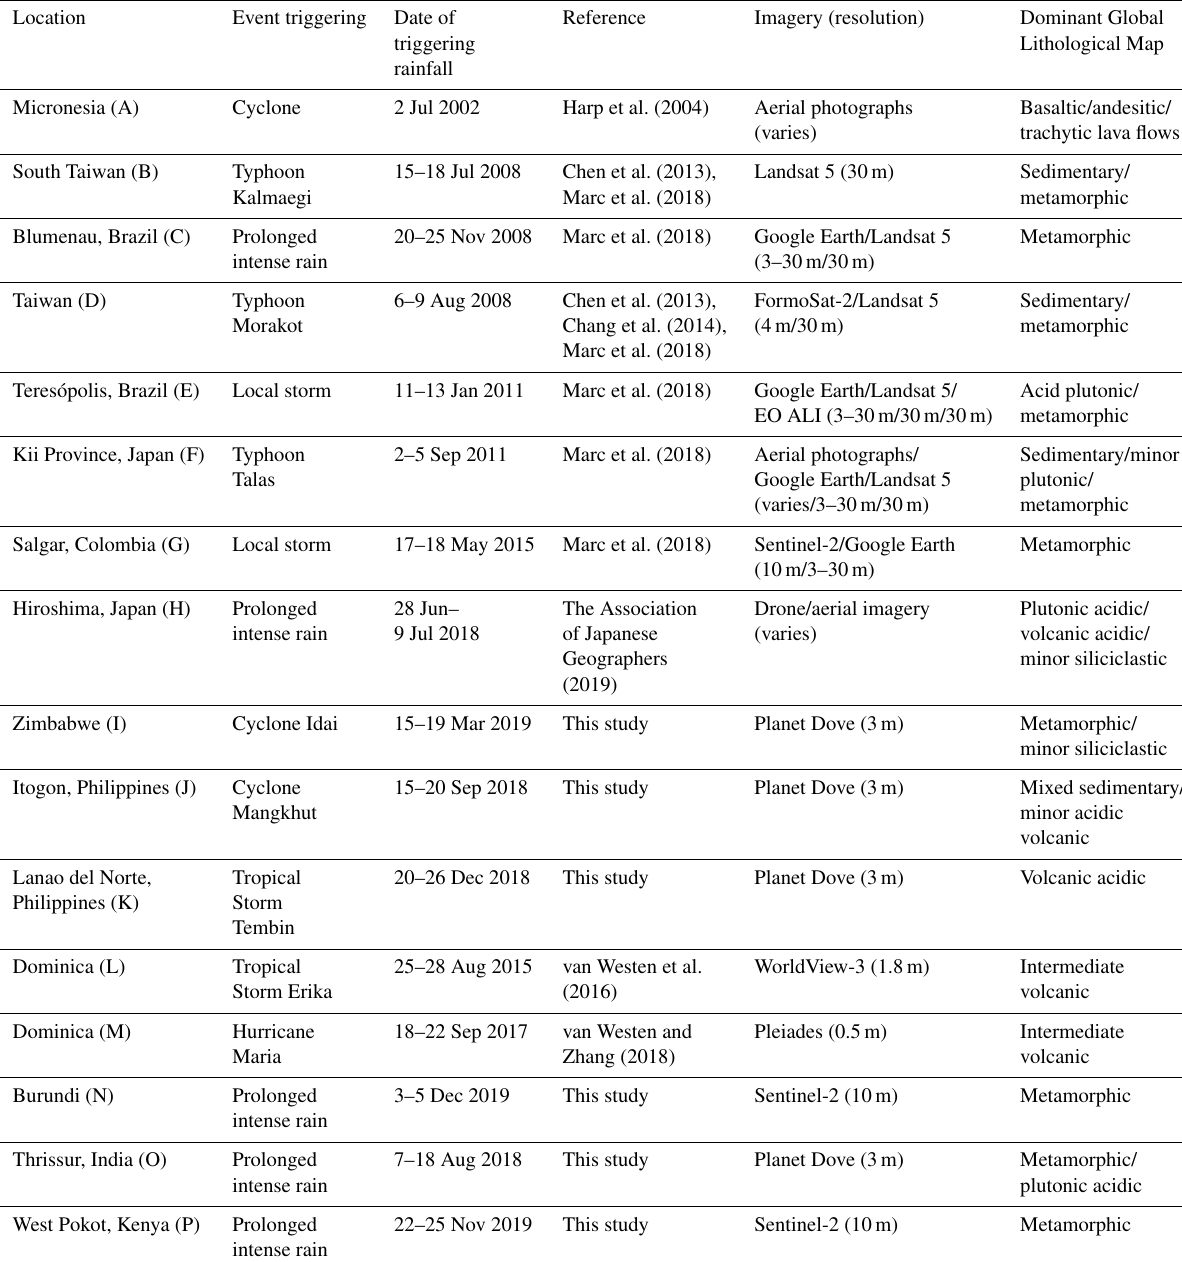
Table 1. Details of landslide inventories analyzed in this